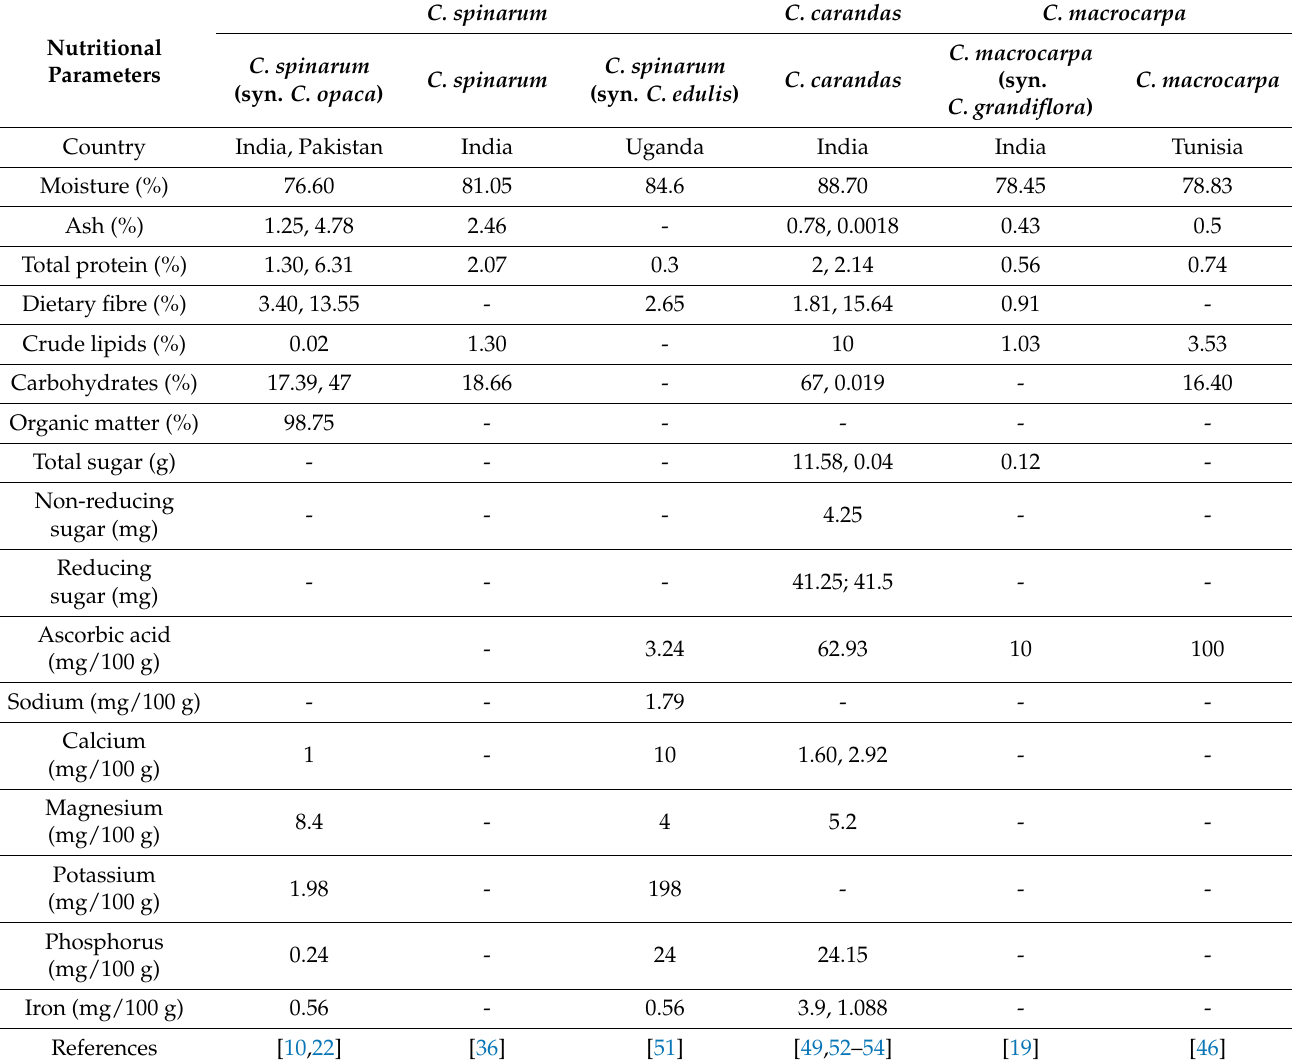
Table 2. Nutritional profile of Carissa